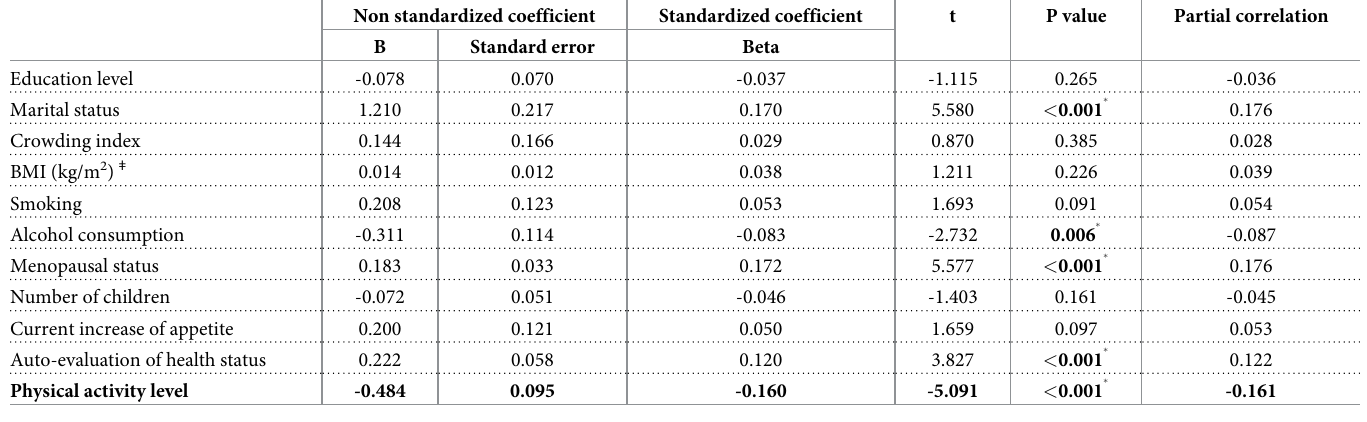
Table 9. Multiple regression of factors associated with the sexual